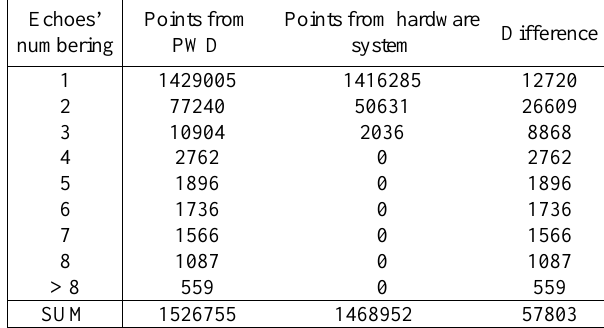
Table 1. Comparison of points from the hardware system and PWD method decomposition